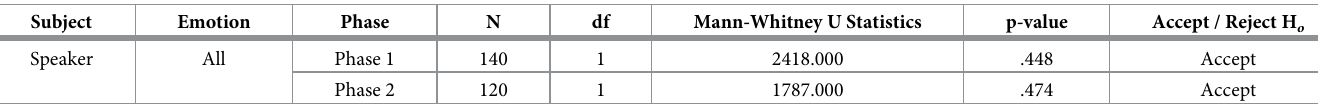
Table 25. Mann Whitney U test for speaker gender.